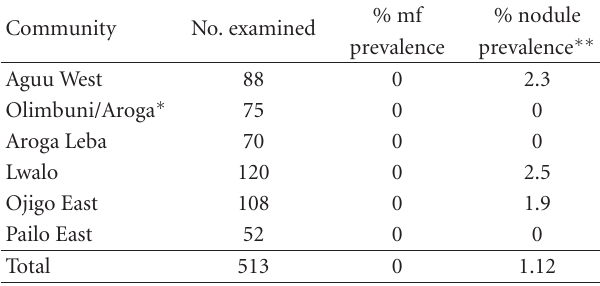
Table 1: Prevalence of skin snips (microscopy) and nodules in